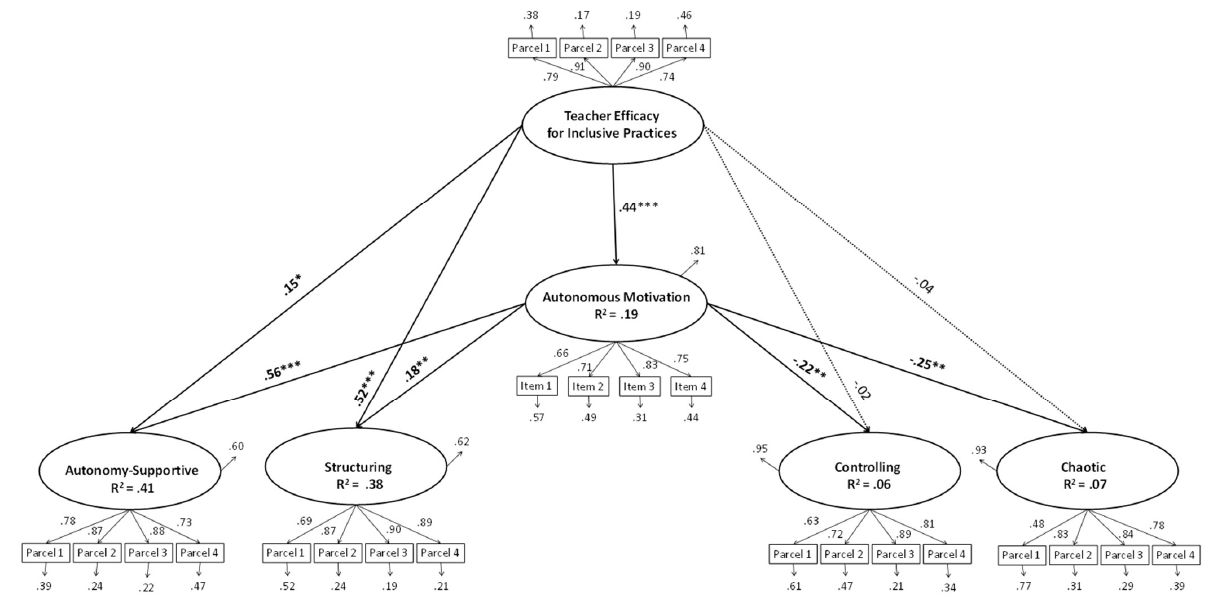
Figure 1. Path diagram depicting the relationships between study variables. Note: *** p ≤ 0.001, ** p ≤ 0.01, * p ≤ 0.05. Coefficients shown are standardized path coefficients. Dotted lines represent non-significant parameters. Table 2. Path estimates, SEs and 95%